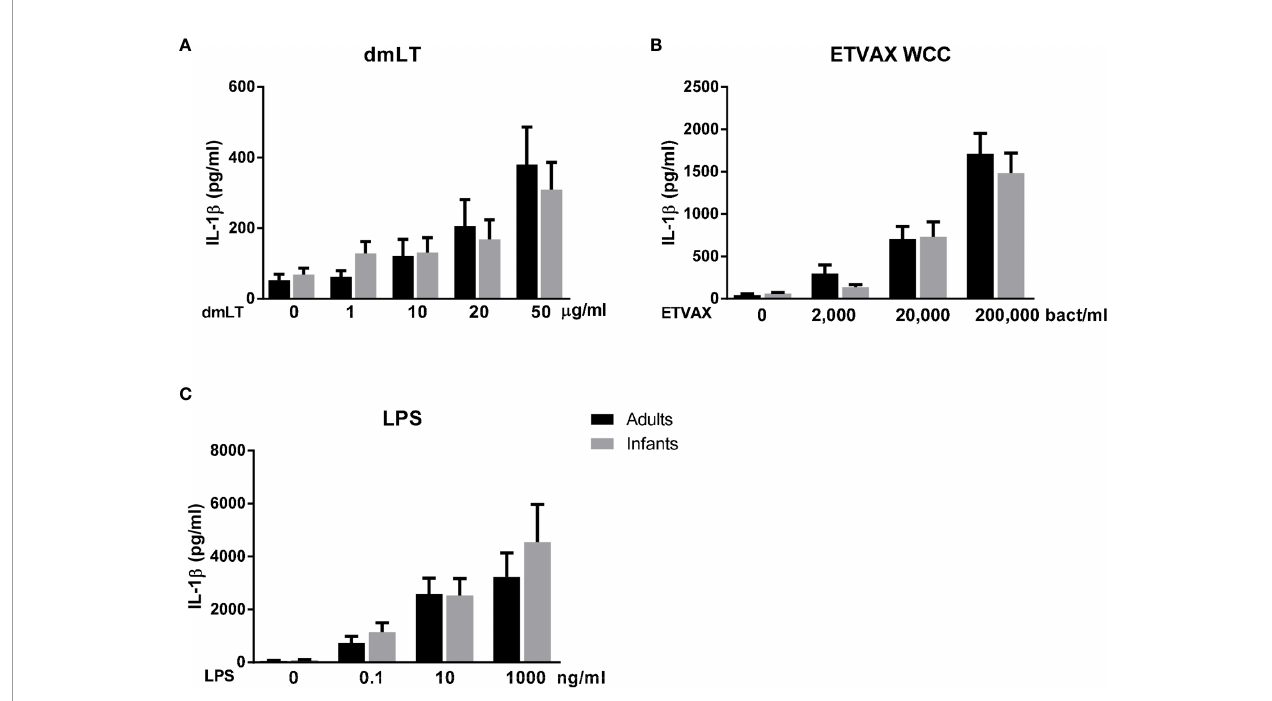
FIGURE 4 | IL-1 b production from PBMCs from adults and infants stimulated with dmLT or ETVAX WCC. IL-1 b concentrations in cultures with cells from PBMCs from adults and infants with increasing concentrations of (A) dmLT (1-50 µg/ml, adults; n = 10, infants; n = 8), (B) ETVAX WCC (2000-200,000 bacteria/ml, adults; n=13, infants; n = 13) or (C) ETEC O78 LPS (0.1-1000 ng/ml, adults; n = 9, infants; n = 8). Bars represent means with SEM of concentrations of IL-1 b in culture supernatants. P > 0.05 for comparisons of IL-1 b concentrations in cultures with cells from adults versus infants at all stimuli concentrations tested (Mann-Whitney